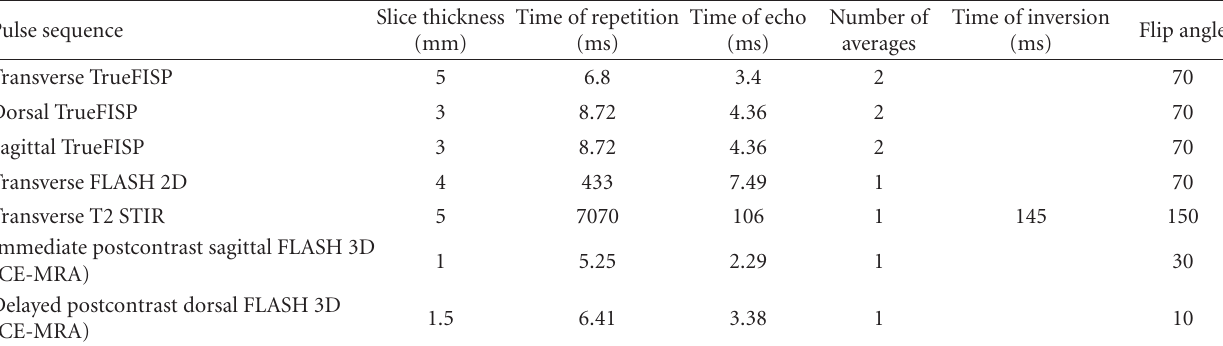
Table 1: Magnetic resonance imaging